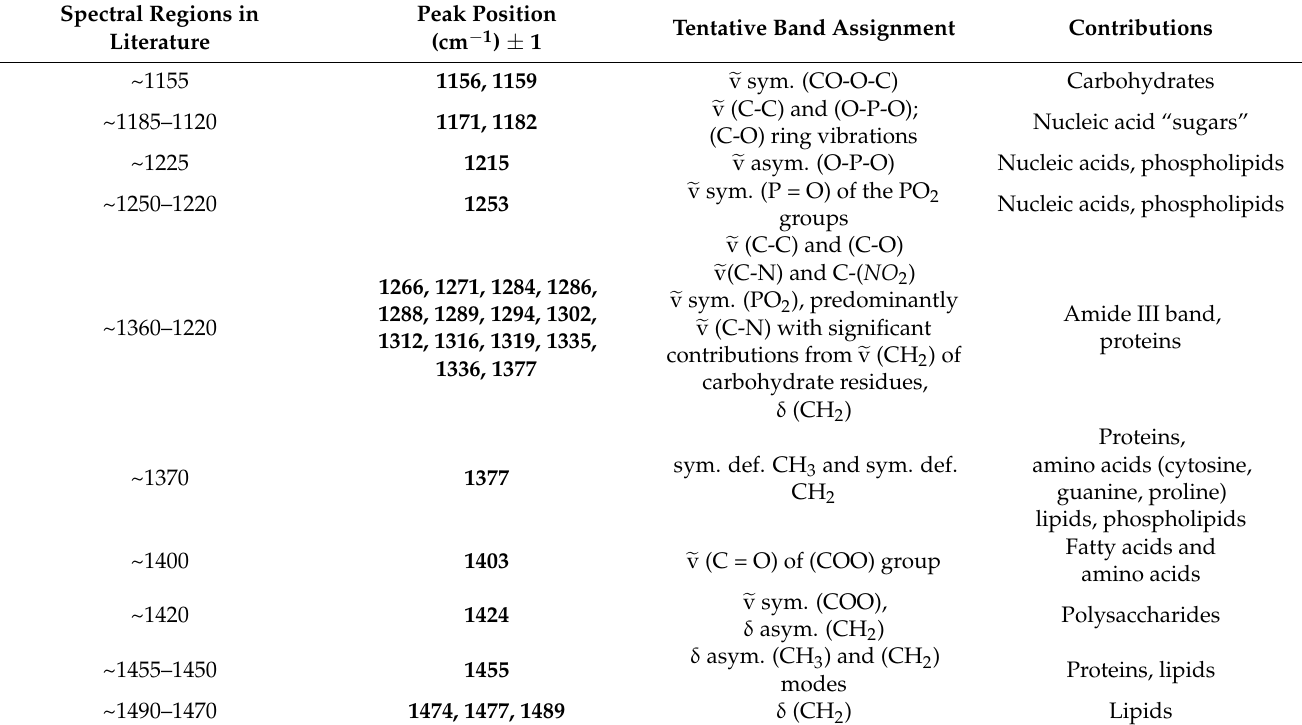
Table A1. Biochemical tentative assignments of the most discriminant wavenumbers selected by SELECT-LDA in the global classification approach aimed at differentiating between PD, AD, and healthy